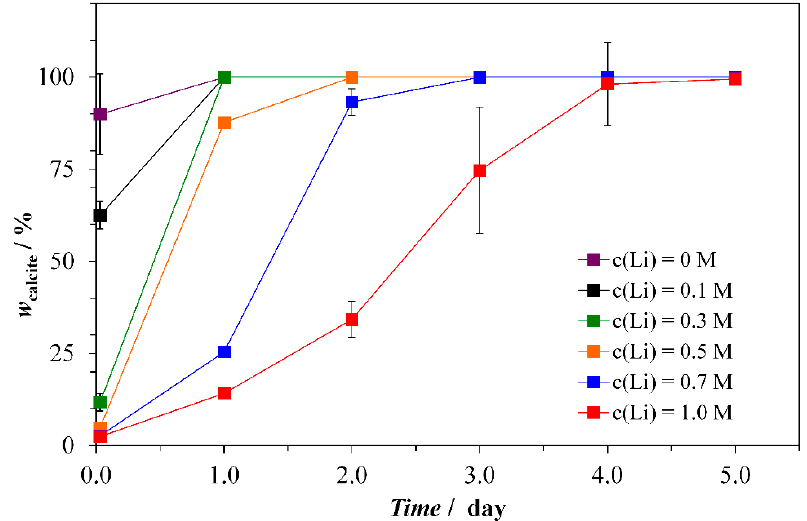
Figure 1. Content of calcite in a mixture with vaterite during the transformation process in the precipitation systems, c i (CaCl 2 ) = c i (NaHCO 3 ) = 0.1 mol dm –3 , with different initial concentrations of Li + . In the reference system, c(Li + ) = 0. The initial concentrations of Li + are indicated: M correspond to mol dm − 3 .